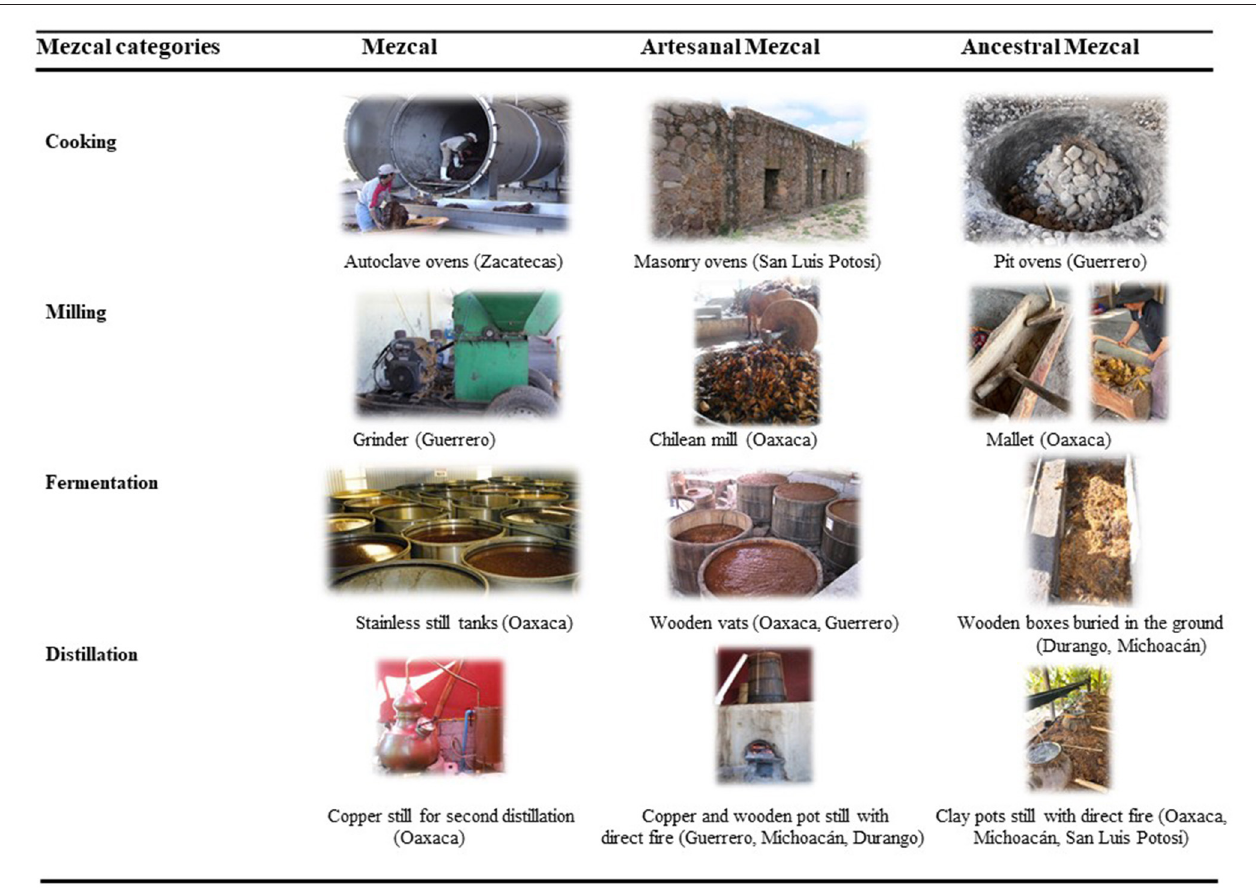
FIGURE 3 | Illustration of the principal steps of the Mezcal production. At each stage, an example of the equipment used for each type of mezcal is presented. The main geographical areas where they are used are mentioned too.